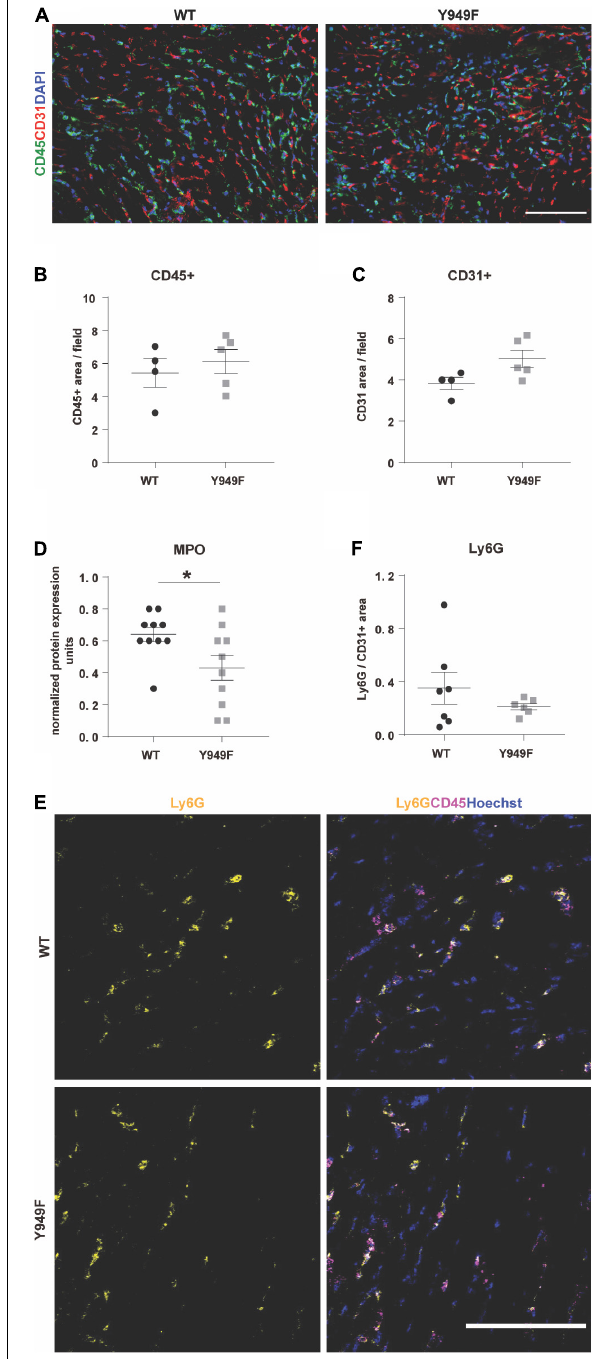
FIGURE 3 | Inflammation, neutrophil infiltration and MPO levels in conjunction with MI. (A) Immunostaining for CD45 (green) and CD31 (red) to visualize infiltrating leukocytes and the vasculature, respectively, in the infarcted areas of WT and Vegfr2 Y 949 F / Y 949 F hearts at 3 days post-MI. DAPI (blue) shows nuclei. Scale bar, 100 µ m. (B,C) Quantification of CD45-positive and CD31-positive area/field ( n = 4–5 individual hearts/strain, 5 fields/section, and 3 sections/heart) in the infarcted part of the heart shows no significant differences using Mann–Whitney test. (D) Myeloperoxidase (MPO)